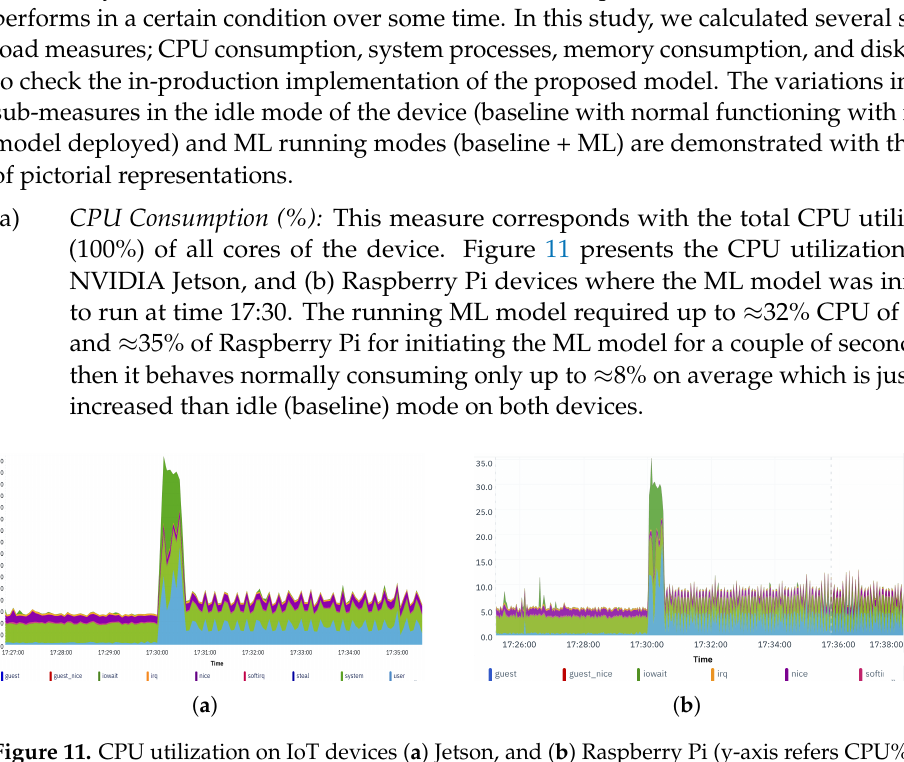
Figure 11. CPU utilization on IoT devices ( a ) Jetson, and ( b ) Raspberry Pi (y-axis refers CPU% used).